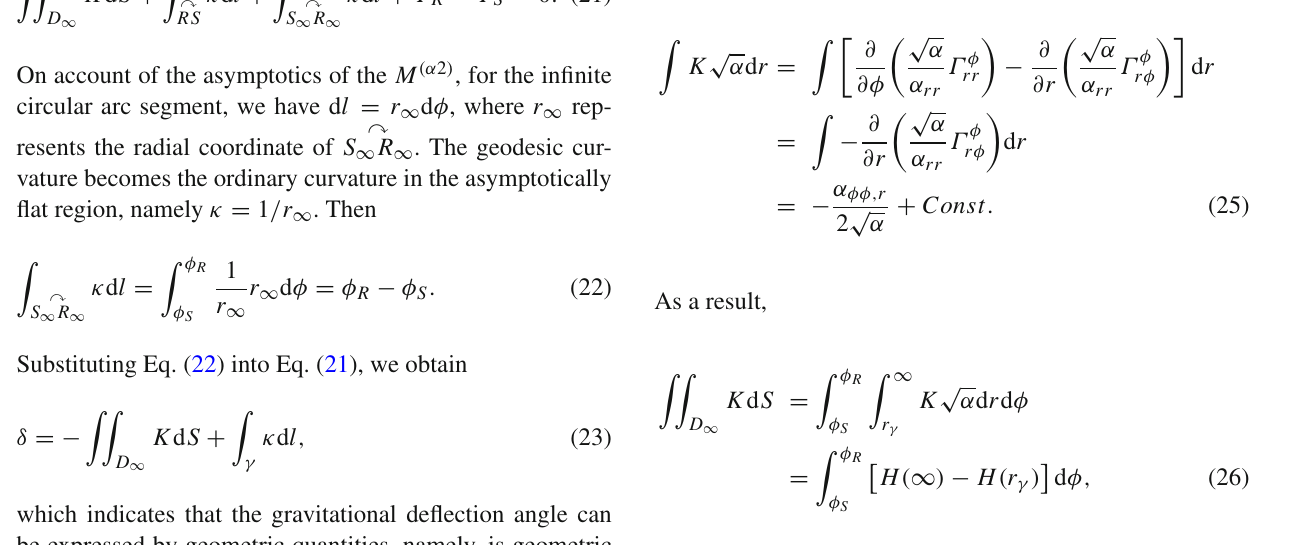
and R ∞ are π/ 2. The Euler characteristic number χ( D ∞ )